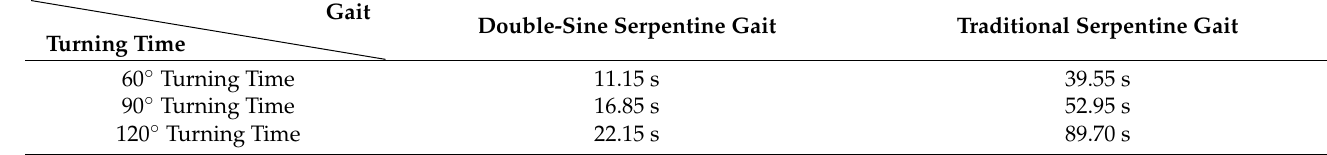
Table 4. Comparison of turning time.